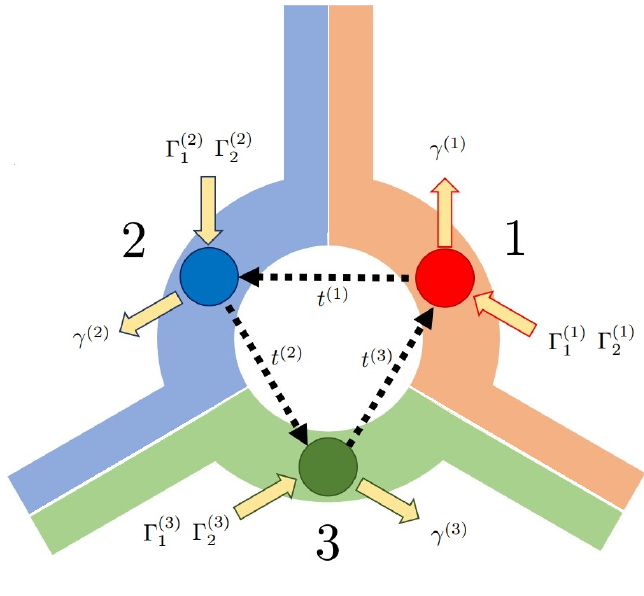
Figure 1: Sketch of the minimal configuration for the open quantum crossroad. Each dot is associated to an entering road and to the subsequent exit road, including the linking roundabout segment. We assume that, to each dot, two monodirectional chains are coupled, injecting and removing vehicles with rates given by Γ γ ( (cid:96) ) , respectively. The motion inside the roundabout is ruled by the hopping terms proportional to t ( (cid:96) )